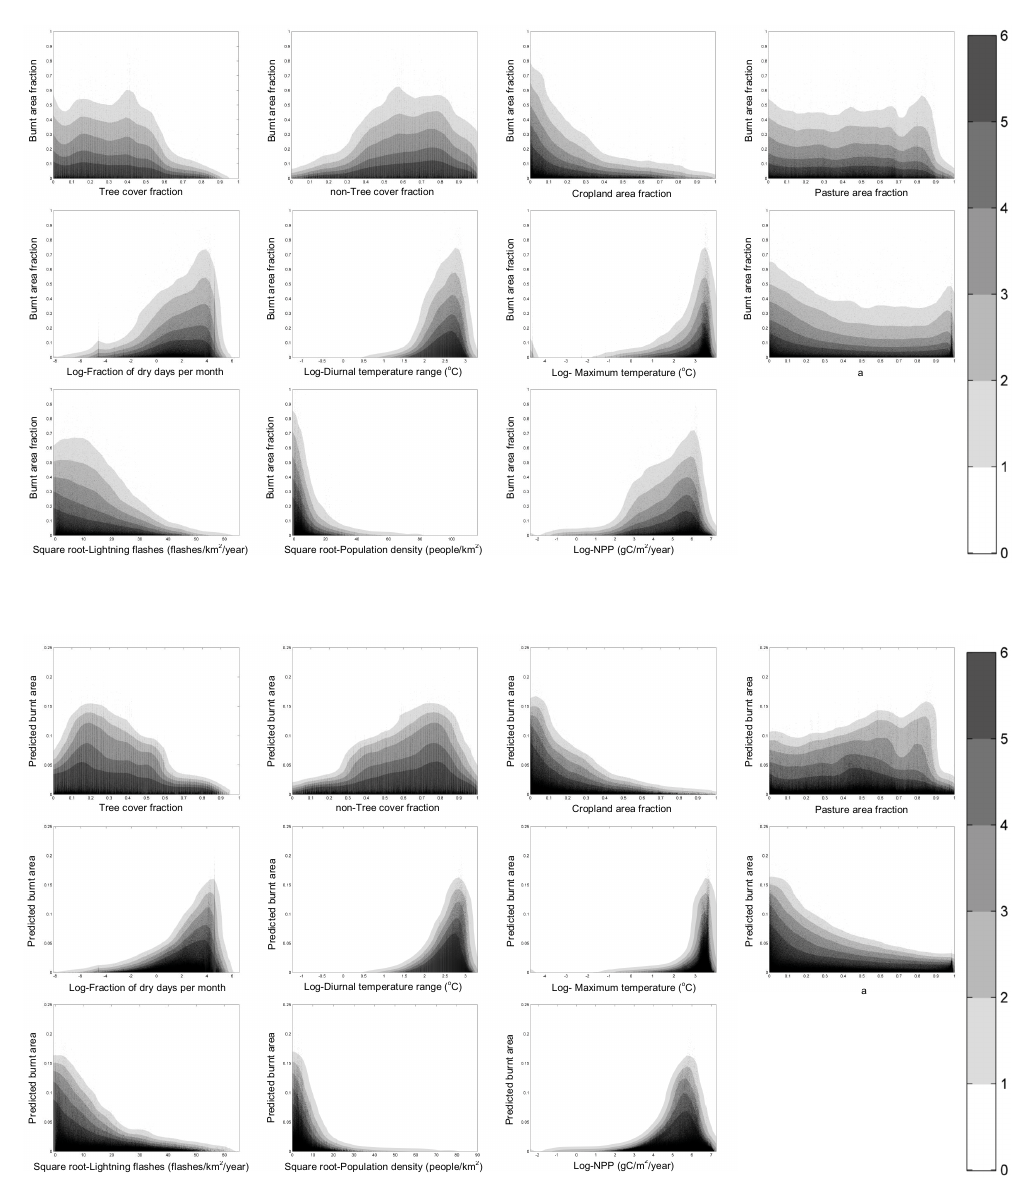
Figure 3. Emergent patterns: observed burnt area and predicted probabilities plotted against each predictor variable in turn. We show the density of the data superimposed onto logarithmic density using 50